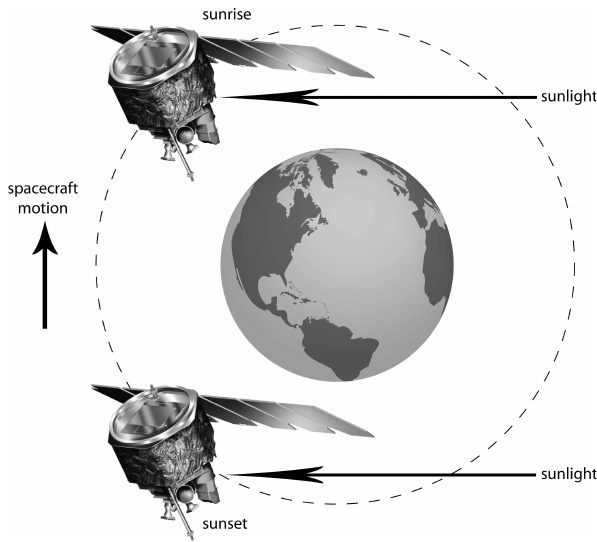
Fig. 1. Solar occultation